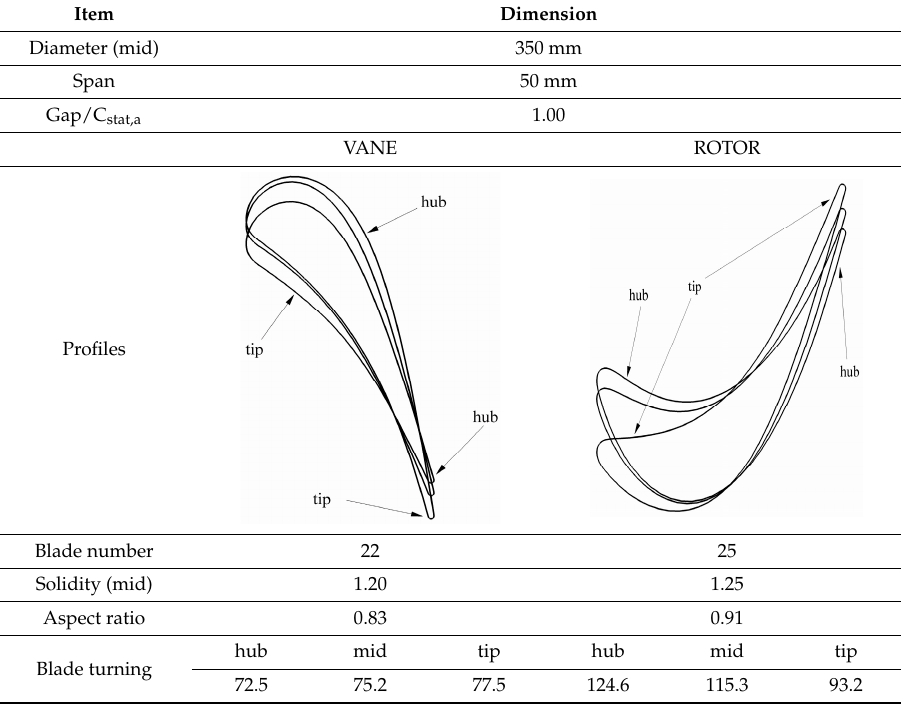
Table 2. Measurement expanded uncertainties, 5HP: 5-Hole Probe; FRAPP: Fast Response Aerodynamic Pressure Probe.